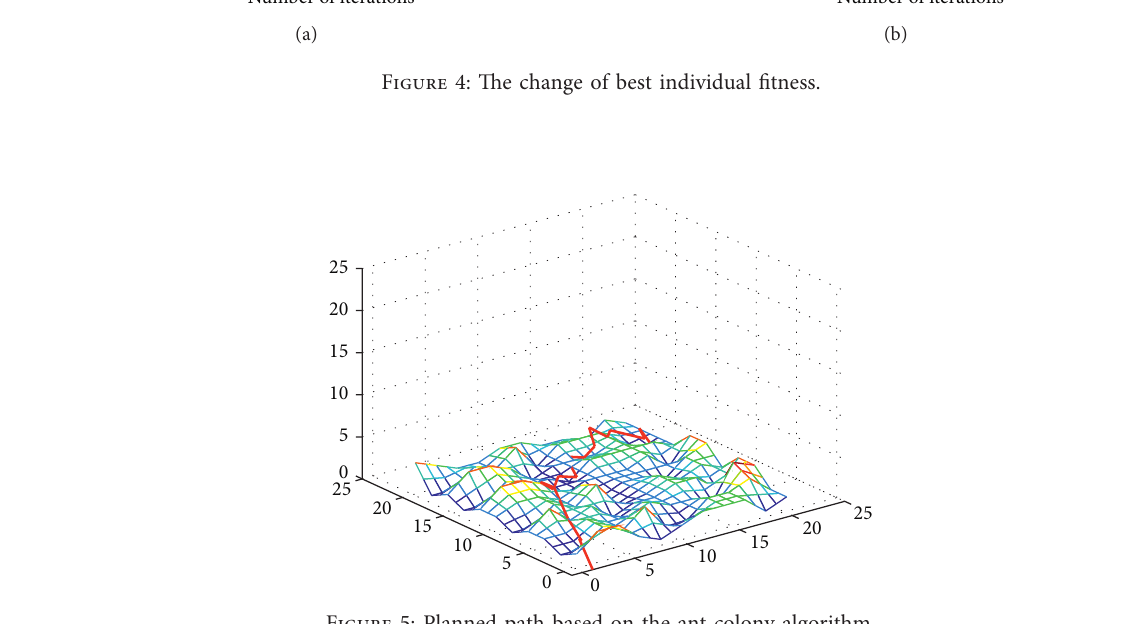
Figure 5: Planned path based on the ant colony algorithm.